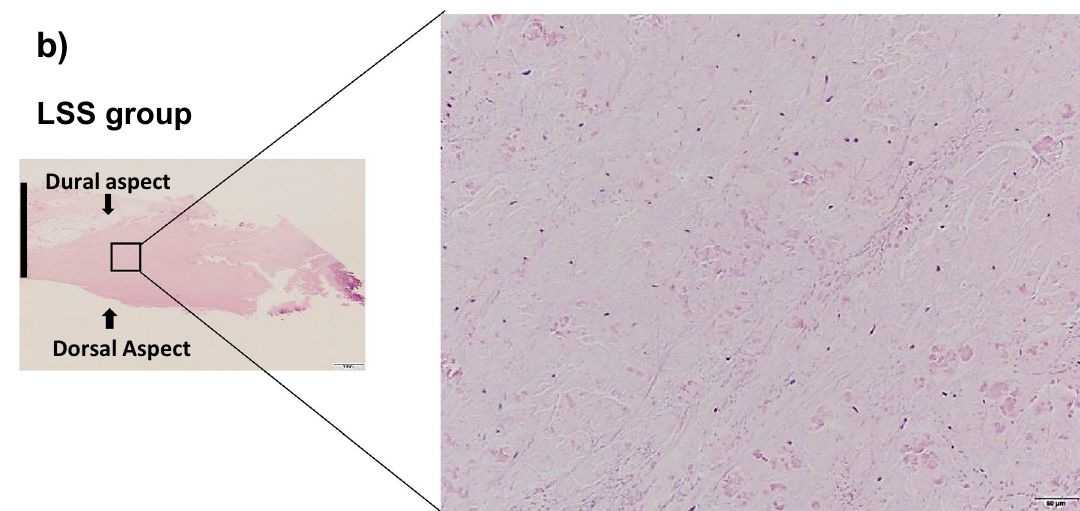
Figure 1. HE staining of ( a ) non-hypertrophied (control) LF and ( b ) hypertrophied LF. Left, low magnification (×1.25; scale bar represents 1 mm); dorsal and dural aspects are indicated, and black line marks the mid-line. Right, high magnification (×20) of boxed area in left image (scale bar represents 50